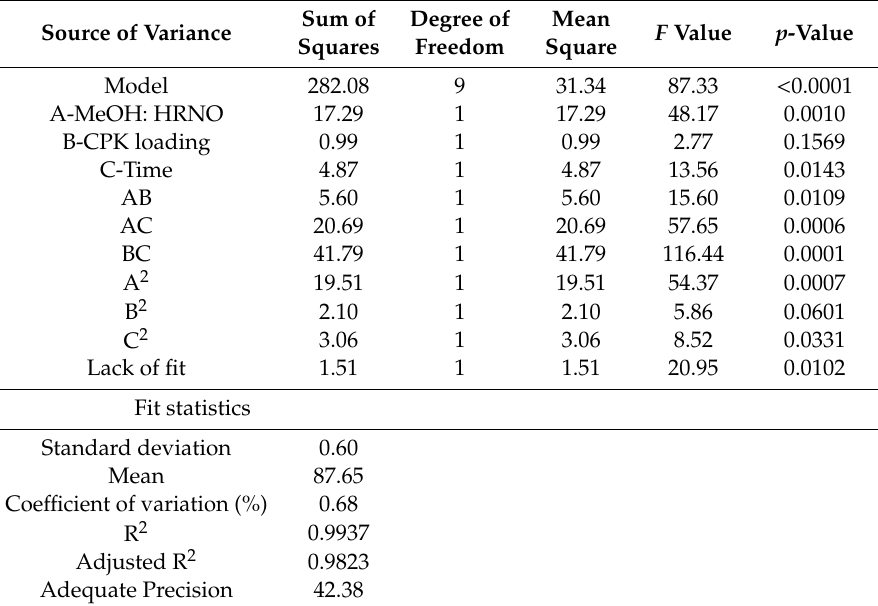
Table 4. Statistical results for the